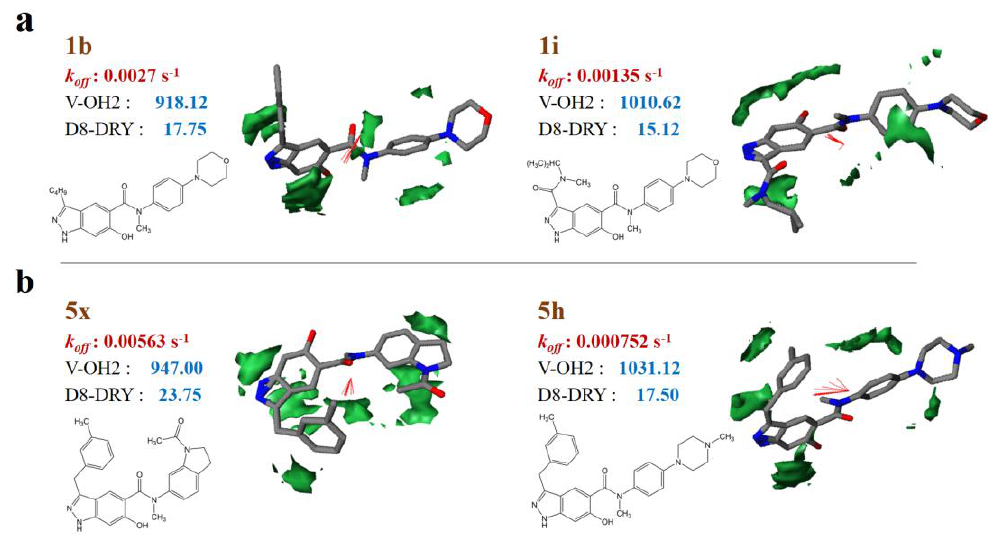
Figure 2. VolSurf properties of representative samples with di ff erent molecular skeletons. ( a ) 1b and 1i; ( b ) 5 × and 5h. The hydrophobic regions at − 1.6 kcal / mol energy level; red vectors represent the integy moments joining the center of mass of the molecule to the barycenter of the hydrophobic regions.